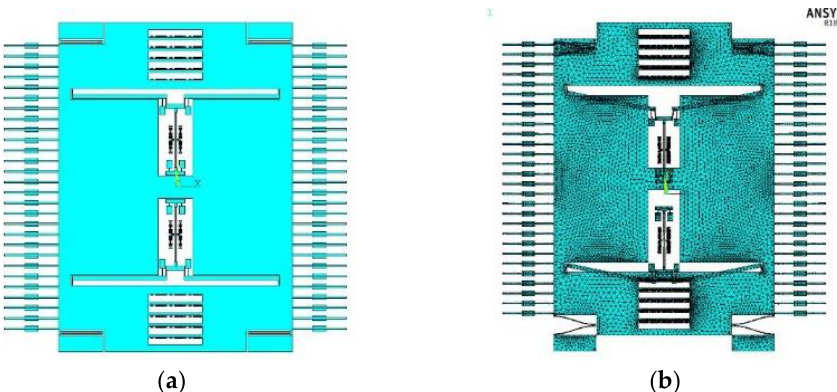
Figure 4. ( a ) The structural model and ( b ) the operating mode of the proof mass.